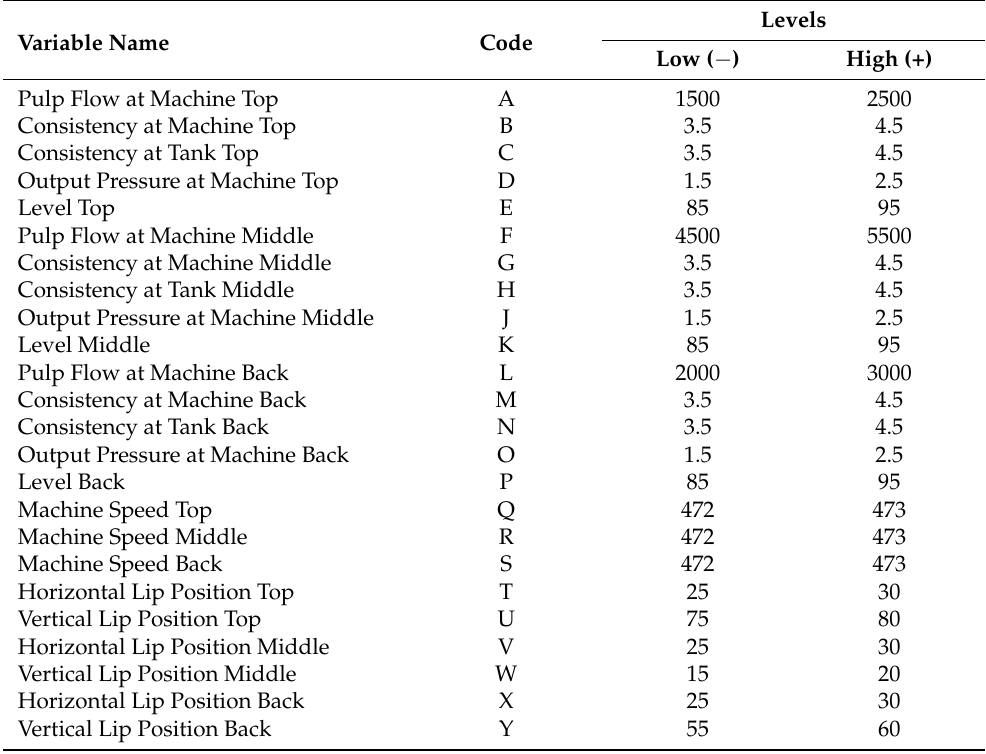
Table 2. Codes and levels of independent variables affecting basis